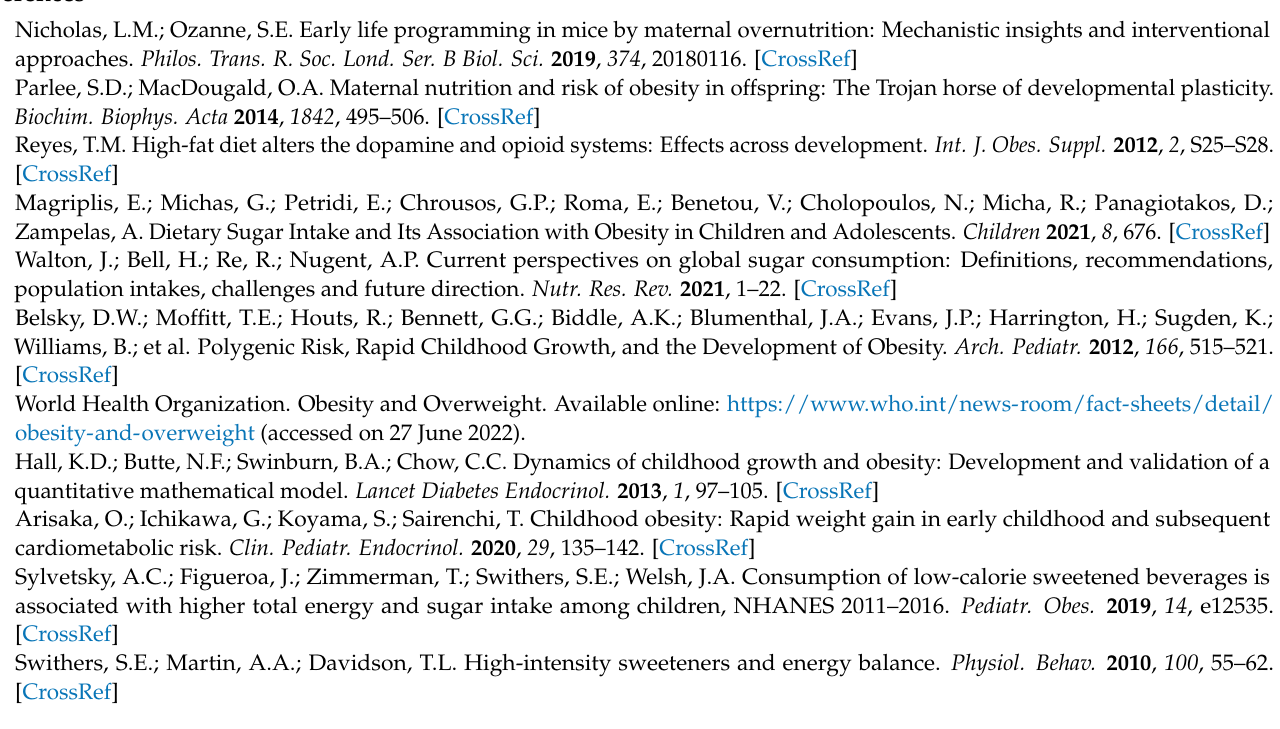
Figure S2: Expanded analyses of water intake and cafeteria diet consumption over time for early life sugar-exposed (10% kcal) rats, Supplementary Figure S3: Expanded analyses of water intake and cafeteria diet consumption over time for early life stevia-exposed rats, Supplementary Figure S4: Percentage of total calories consumed from cafeteria diet components during adult